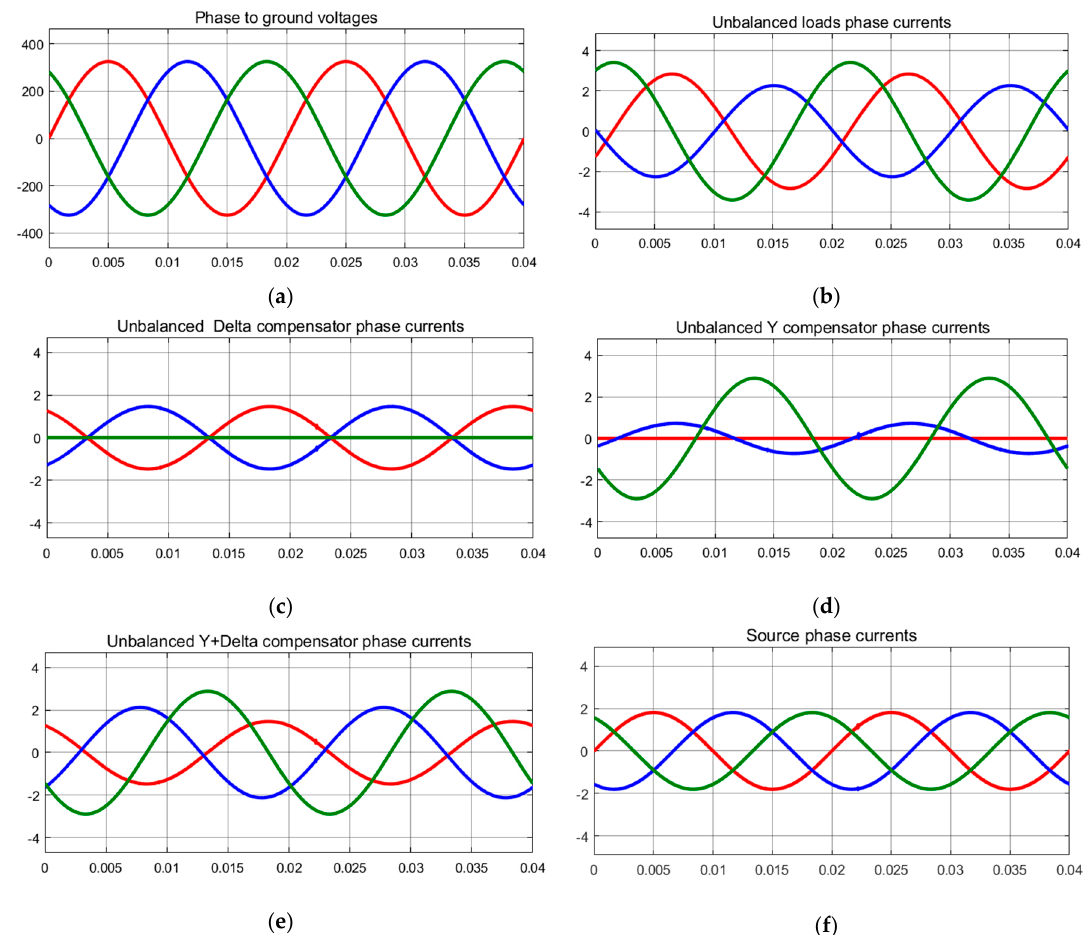
Figure 3. Waveforms of phase to neutral voltages and currents in the sections of the load-compensator assembly: ( a ) phase to neutral voltages; ( b ) currents on the load phases; ( c ) currents on the Δ compensator phases; ( d ) currents on the Yn compensator phases; ( e ) currents on the Yn + Δ compensator phases; ( f ) currents on the load-compensator assembly phases (PCC).